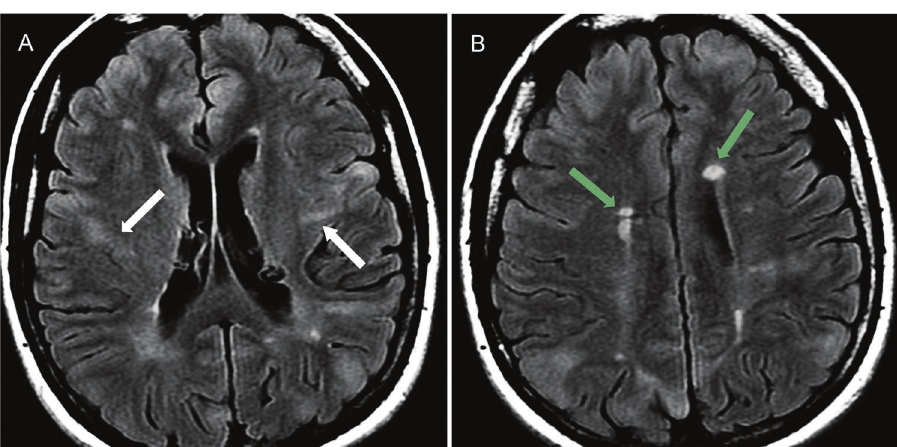
Figure 5 - Tuberous sclerosis in a 21-year-old female with drug-resistant partial epilepsy. A) Axial FLAIR images show hyperintense cortical tubers with a band of abnormal signal intensity from the cortex to the lateral ventricle (white arrows) and B) multiple subependymal hamartome (green arrows) with a hyperintense signal.